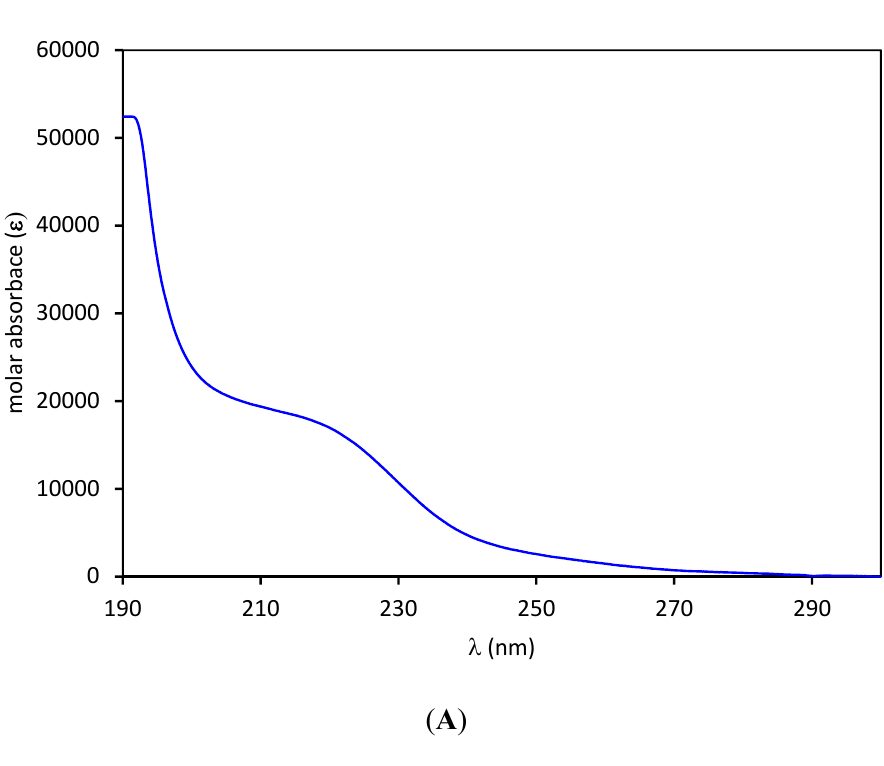
Figure A8. UV ( A ) and CD ( B ) spectra of compound 1 (MeOH).